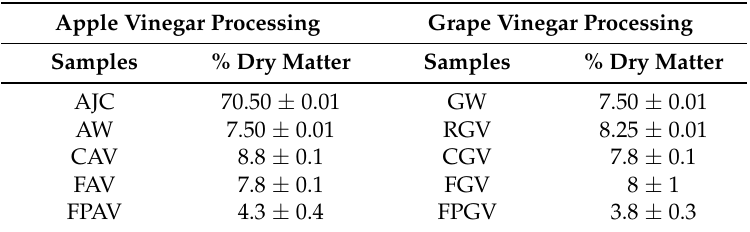
Table 1. The percent dry matter values for the apple and grape vinegar processing